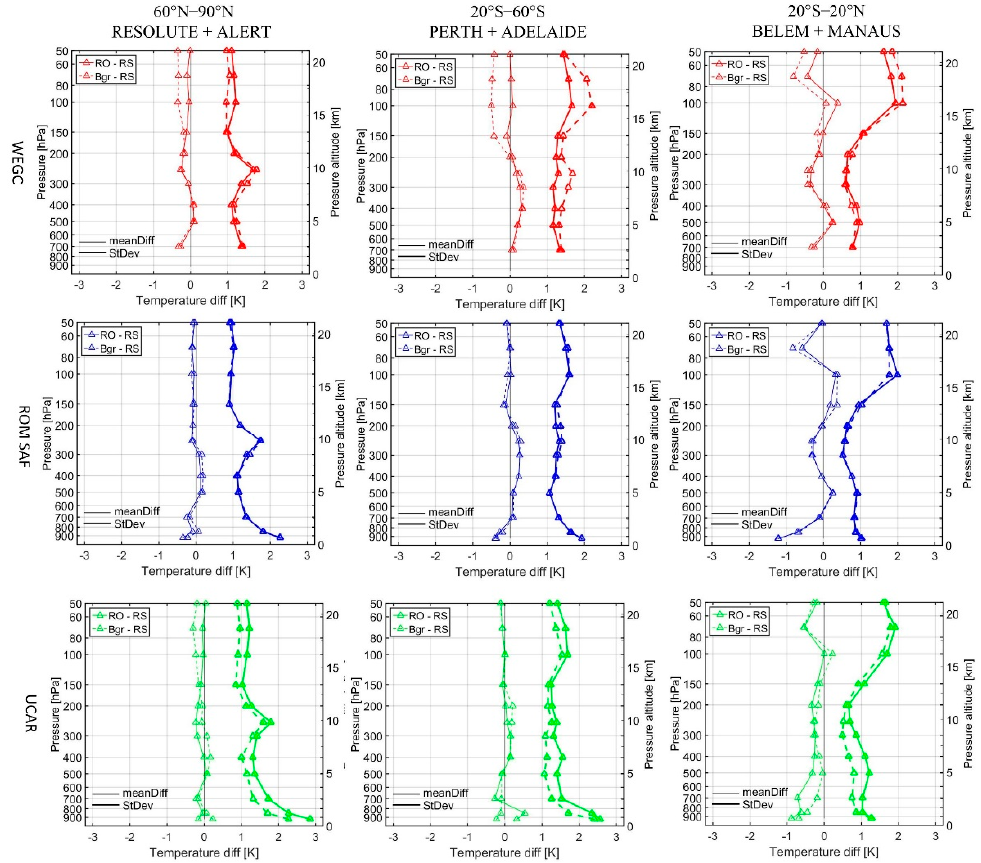
Figure 6. Temperature mean differences (meanDiff) and standard deviations (Stdev) between RO retrieved profiles and RS (RO-RS) and that between background profiles and RS (Bgr-RS) at stations in three selected latitudinal bands of 60°–90°N, 20°–60°S and 20°S–20°N; top, middle and bottom rows show for results of WEGC, ROM SAF and UCAR, respectively.